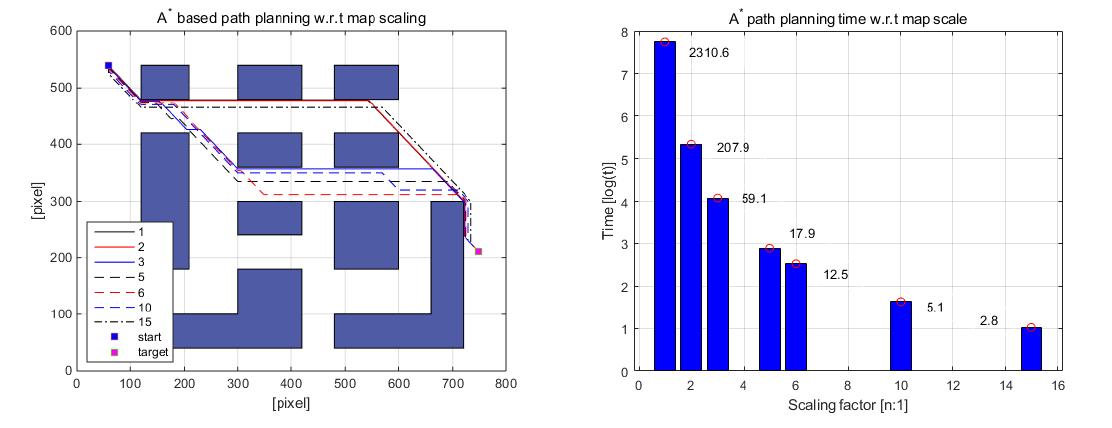
Figure 7. A* path planning time with respect to scaling